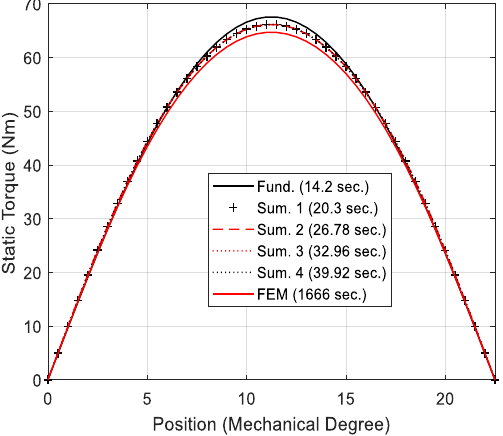
Figure 13. Case four: Static torque comparison.